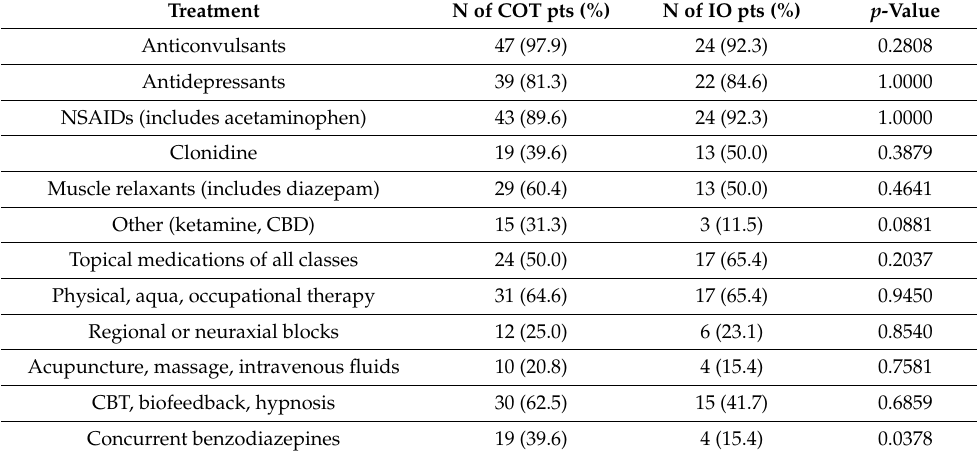
Table 3. Treatments for patients on chronic opioid therapy (COT) and intermittent opioids